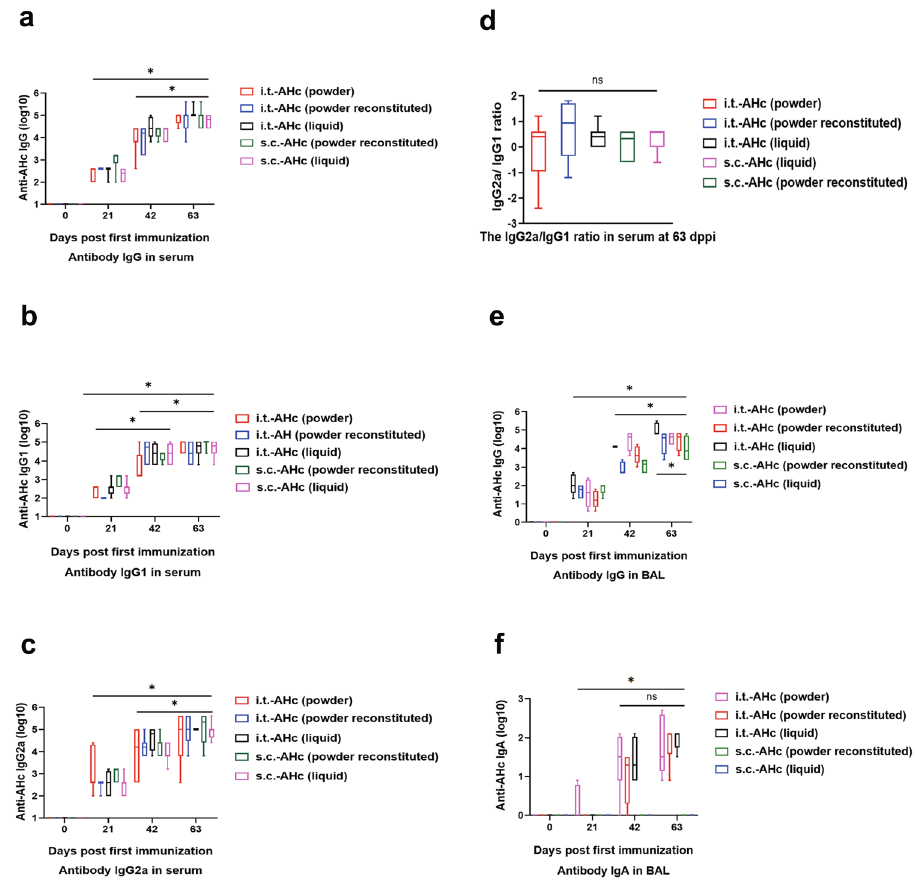
Fig. 3 Antibody responses to AHc, as determined by ELISA. Serum was collected from eight mice from each of the following 12 groups: (1) i. t.-AHc (powder), (2) i.t.-AHc (powder reconstituted), (3) i.t.-AHc (liquid), (4) i.t.-CpG (powder), (5) i.t.-CpG (powder reconstituted), (6) i.t.-CpG (liquid), (7) s.c.-AHc (powder reconstituted), (8) s.c.-AHc (liquid), (9) s.c.-CpG (powder reconstituted), (10) s.c.-CpG (liquid), (11) i.t.-PBS, or (12) s. c.-PBS, at 0, 21, and 42 dppi. Moreover, BAL was collected from four mice per group at 0, 21, and 42 dppi. a The reciprocal titers of IgG to AHc in mouse sera. b The reciprocal titers of IgG1 to AHc in mouse sera. c The reciprocal titers of IgG2a to AHc in mouse sera. d The IgG2a/IgG1 ratio in serum at 63 dppi. e The reciprocal titers of IgG to AHc in mouse BAL. f The reciprocal titers of SIgA to AHc in mouse BAL. The